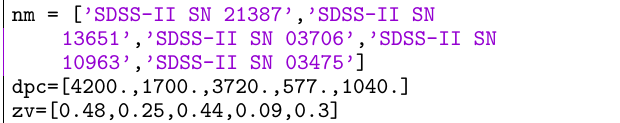
is a scatter plot with red triangle markers with an area (size) of 40 square points, coded as plt.clf()